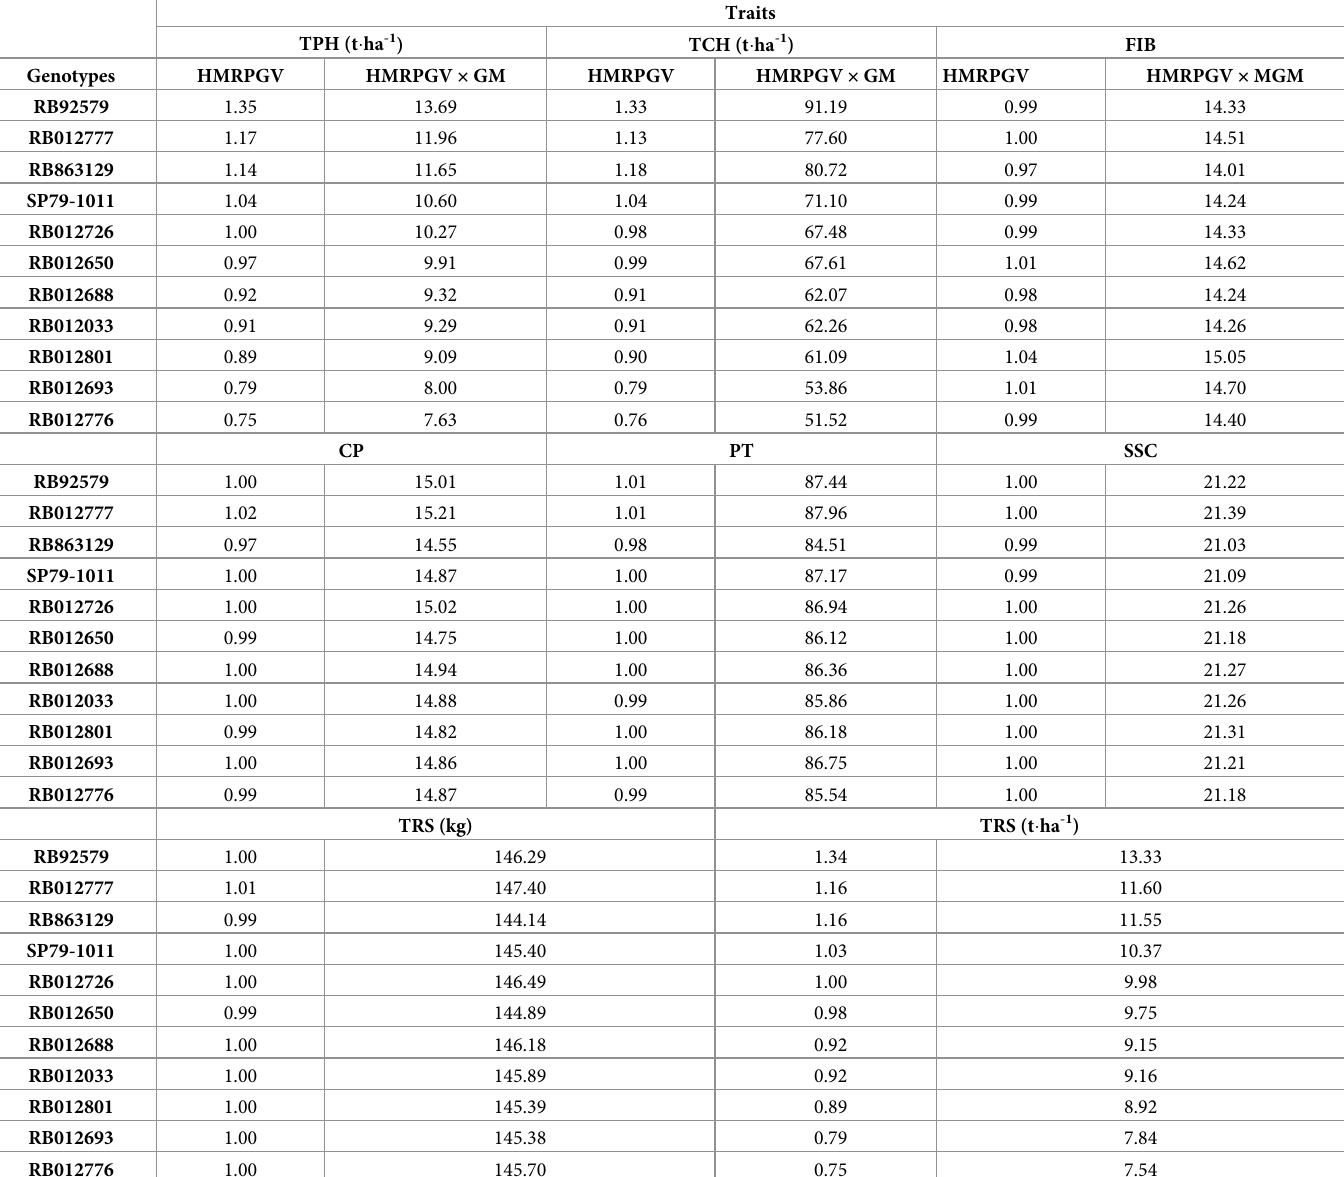
Table 7. Adaptability and stability (harmonic mean of the relative performance of genotypic values (HMRPGV) and HMRPGV × overall mean in all the environ- ments) of the genotypic values of sugarcane genotypes with prediction based on analysis of the best unbiased linear predictor evaluated over two consecutive years during the final phases of trials conducted in sugarcane microregions in the State of